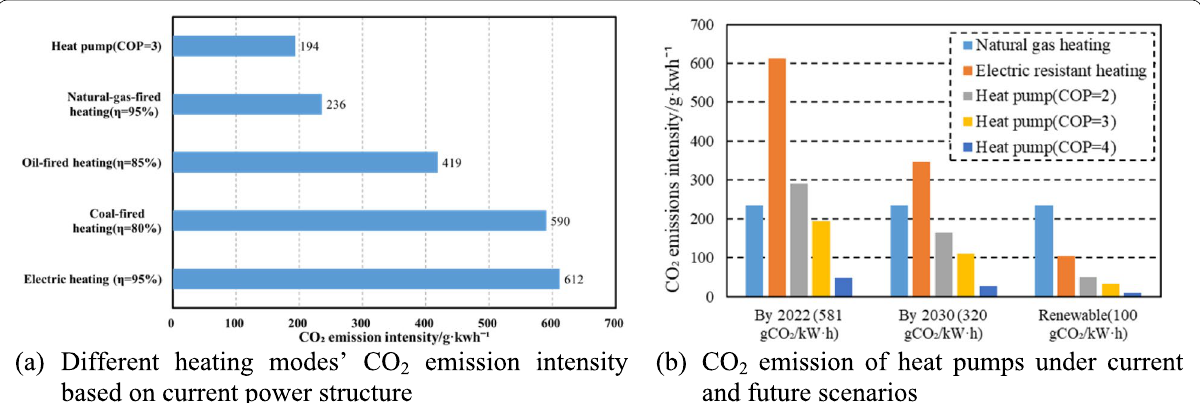
Fig. 9 CO 2 emission evaluation on heat pumps compared with other heating modes. a Different heating modes’ CO 2 emission intensity based on current power structure. b CO